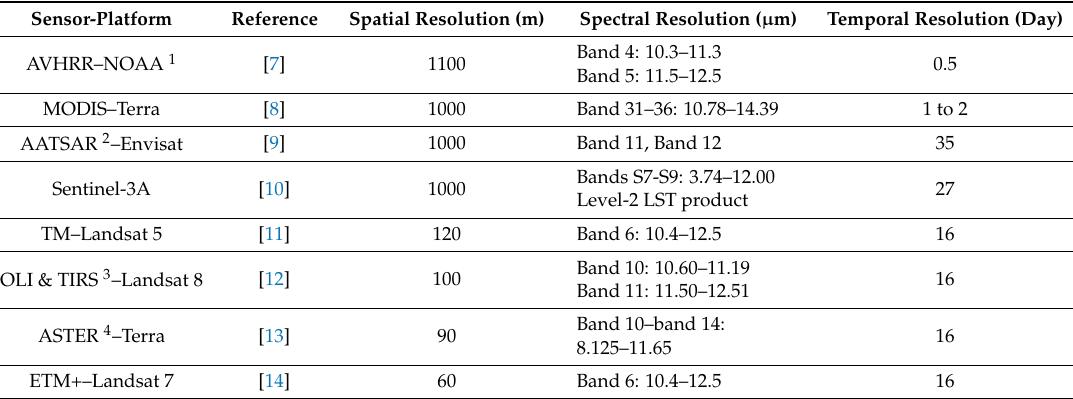
Table 1. Technical characteristics of operational thermal satellite